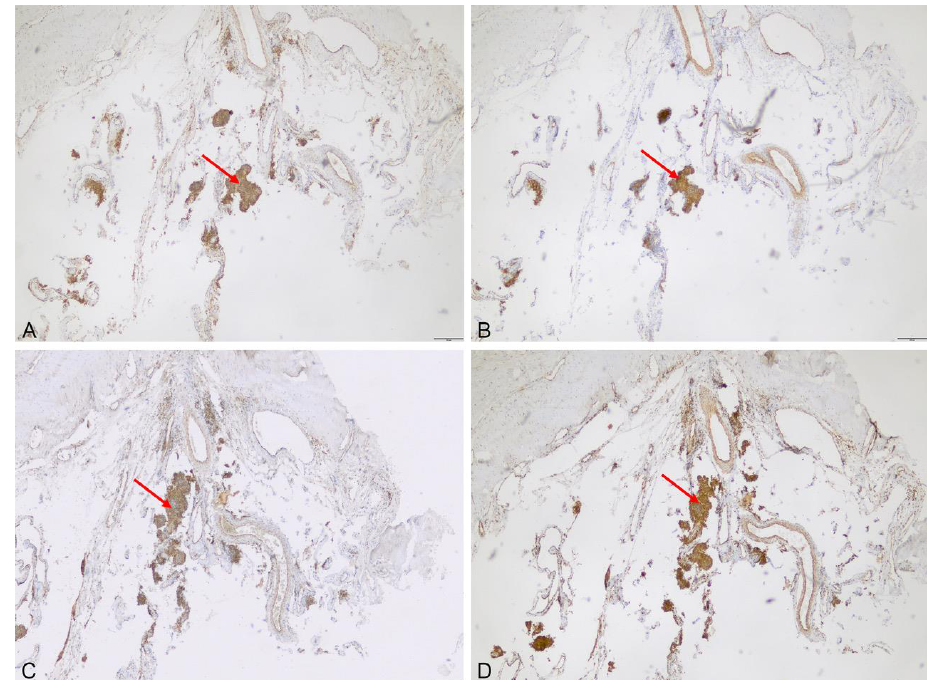
Figure 5. Expression of the analyzed transporters and metabolism enzymes in a non-fluorescent